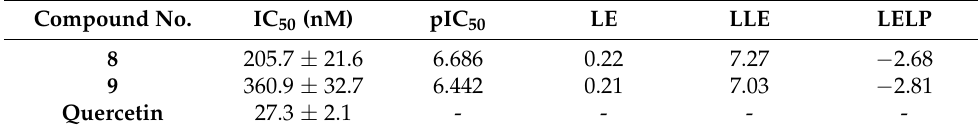
Table 5. In vitro CAII inhibitory activities of 8 and 9 and their ligand efficiency metrics. Compound